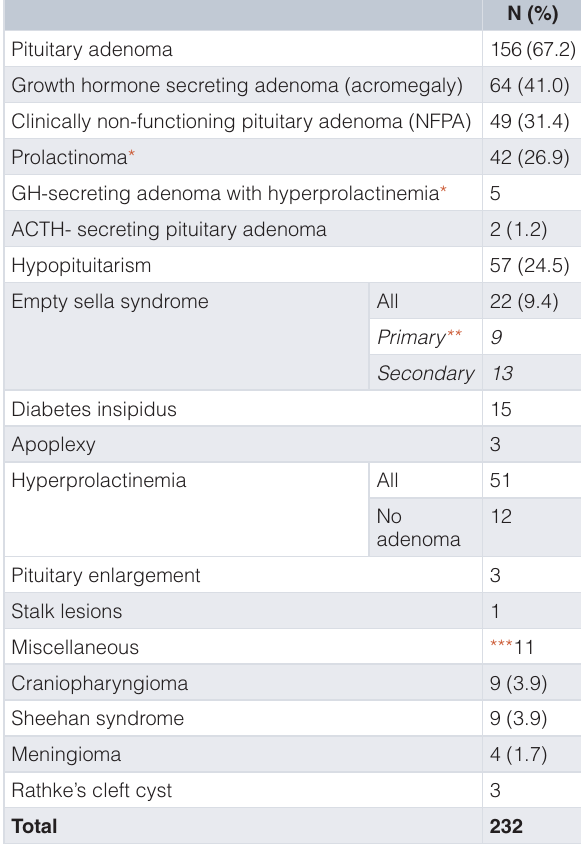
Table 2. Spectrum of pituitary disorders at the time of registry. Table 3. Pituitary adenoma according to the size.